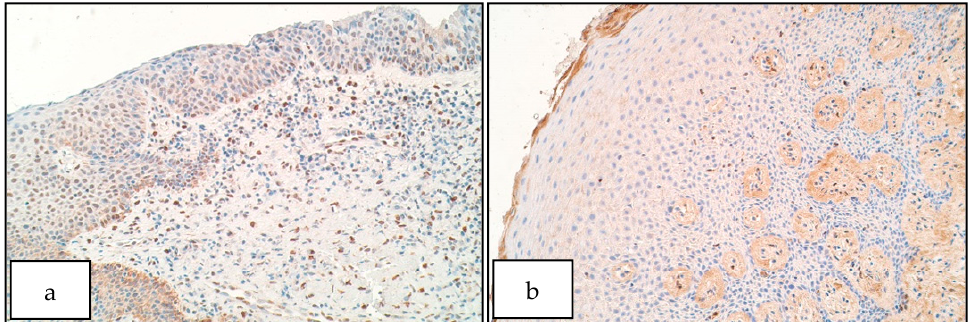
Figure 8. Immunoreactive structures for FOXE1. ( a ) Moderate number of FOXE1 positive structures in patient epithelium and connective tissue, FOXE1 IMH, 200×. ( b ) A few FOXE1 positive structures in control epithelium, FOXE1 IMH, 200×. Table 4. Spearman’s rank correlation coefficient correlations between different tissue factors in the patient group epithelium (r s —Spearman’s rho value). Strength of Correlation r s p -Value Very strong: